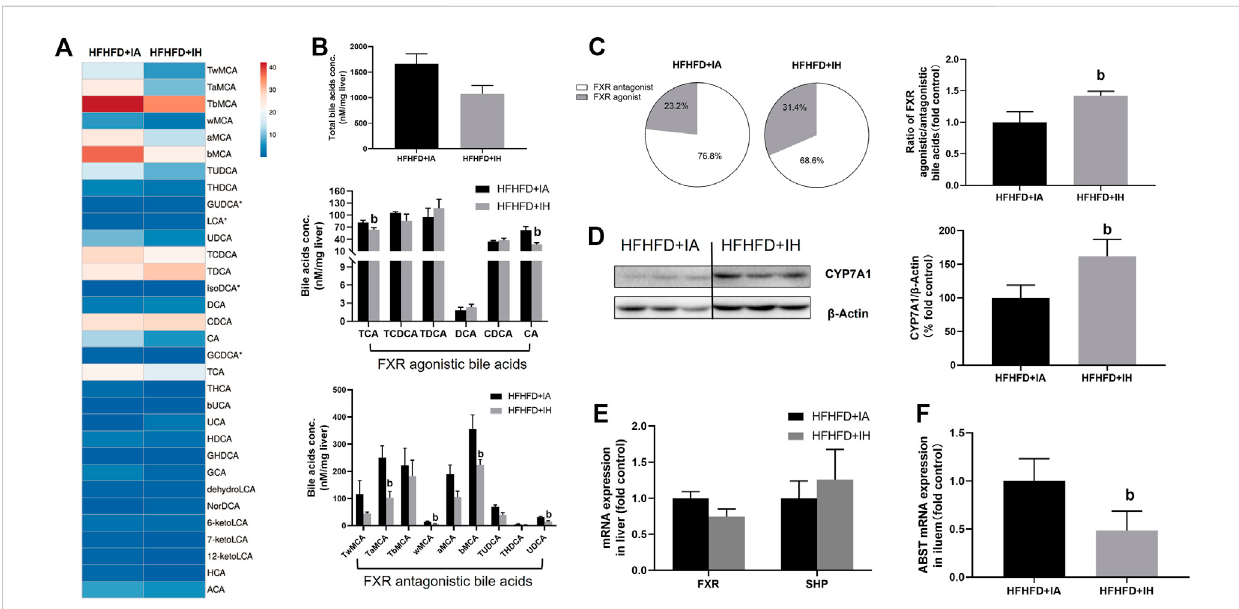
FIGURE 8 The effect of IH in bile acids metabolism in HFHFD-fed mice. (A) Heatmap comparing hepatic bile acids pool in HFHFD + IA versus HFHFD + IH group. (B) TotalhepaticbileacidscontentandcompositionareshowninHFHFD-fedmice. (C) PiechartsforhepaticFXRagonist(grey)/antagonist(white) bile acids content are exhibited. The ratio of FXR agonistic to antagonistic bile acids content is shown in the right panel. (D) Representative western blots and densitometric analysis for CYP7A1 protein are shown. (E) Hepatic mRNA expressions of gene involved in bile acid signaling are shown. (F) Ileal ASBT gene level for bile acids transport is displayed. b, p < 0.05 compared to the absence of IH. Samples size per group n = 4 – 6